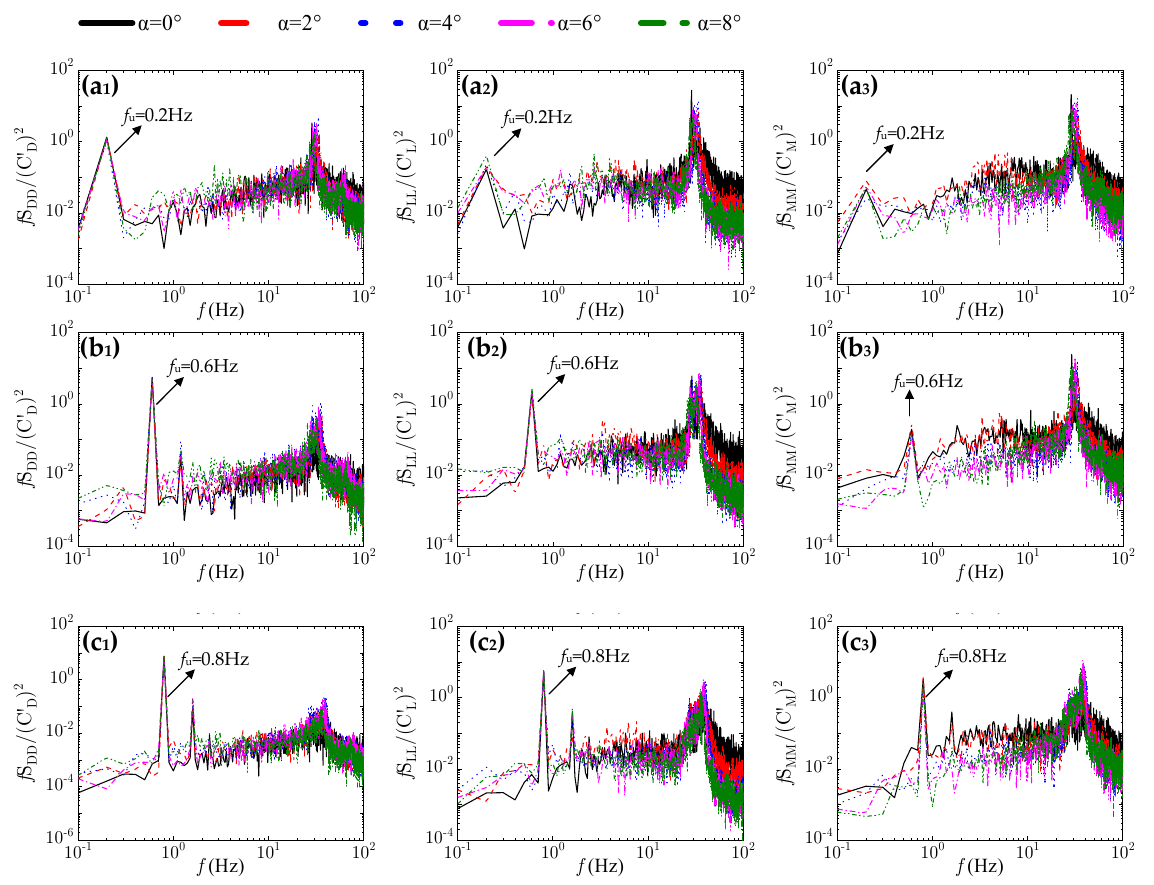
Figure 6. Normalized PSD of C D , C L , and C M in significant sinusoidal flows. ( a1 – a3 ): Case SF (0.2, 0.0625); ( b1 – b3 ): Case SF (0.6, 0.125); ( c1 – c3 ): Case SF (0.8, 0.25).